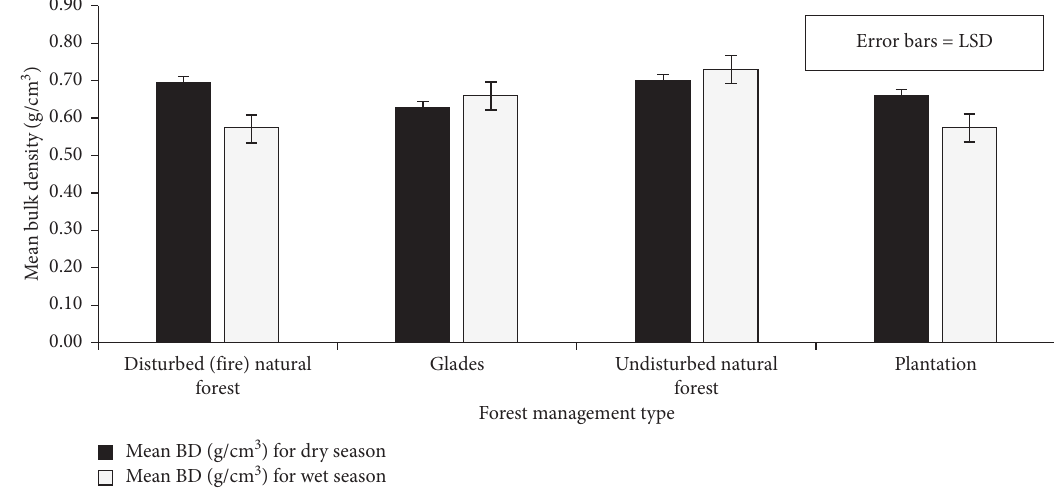
Figure 6: Soil bulk density under different forest management